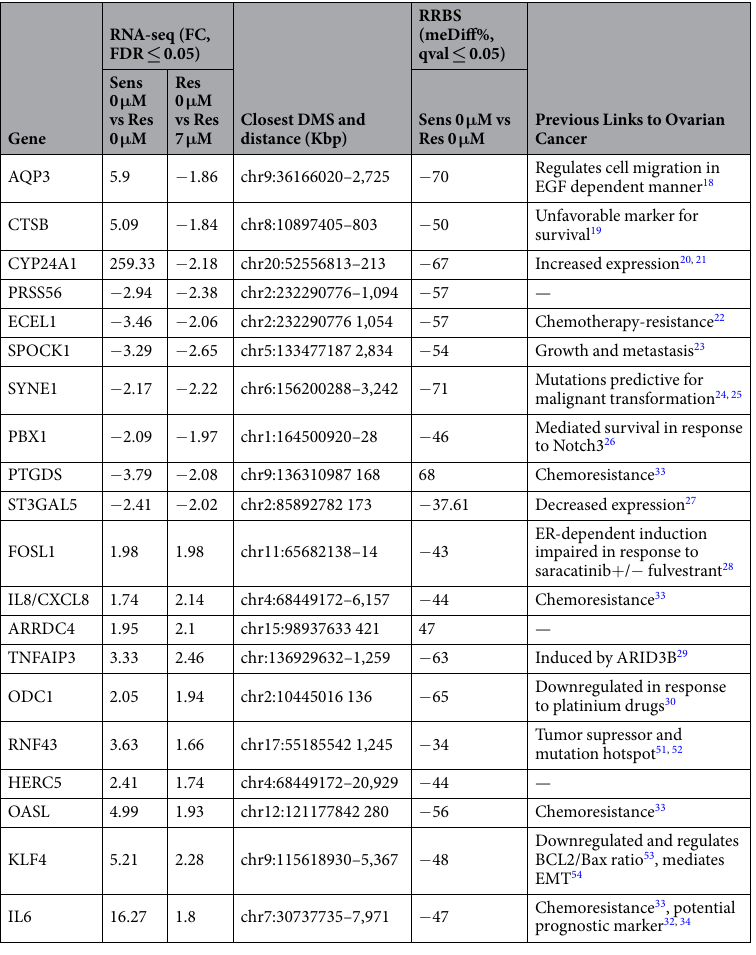
Table 1. The potential drug resistance driver